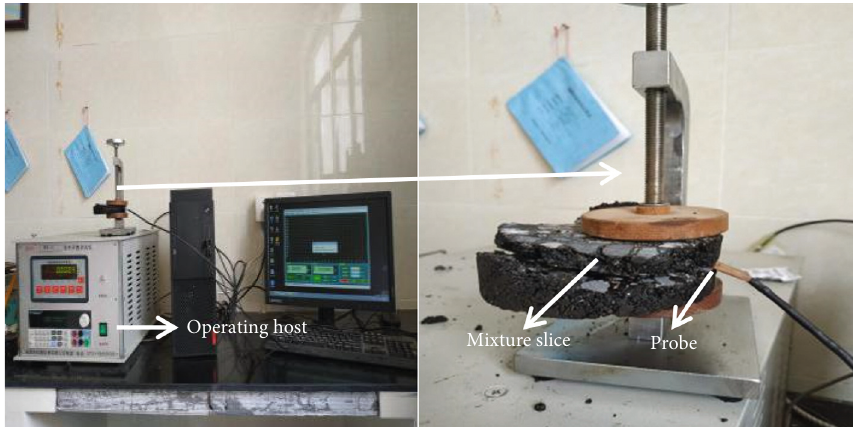
Figure 3: Testing instrument of thermal